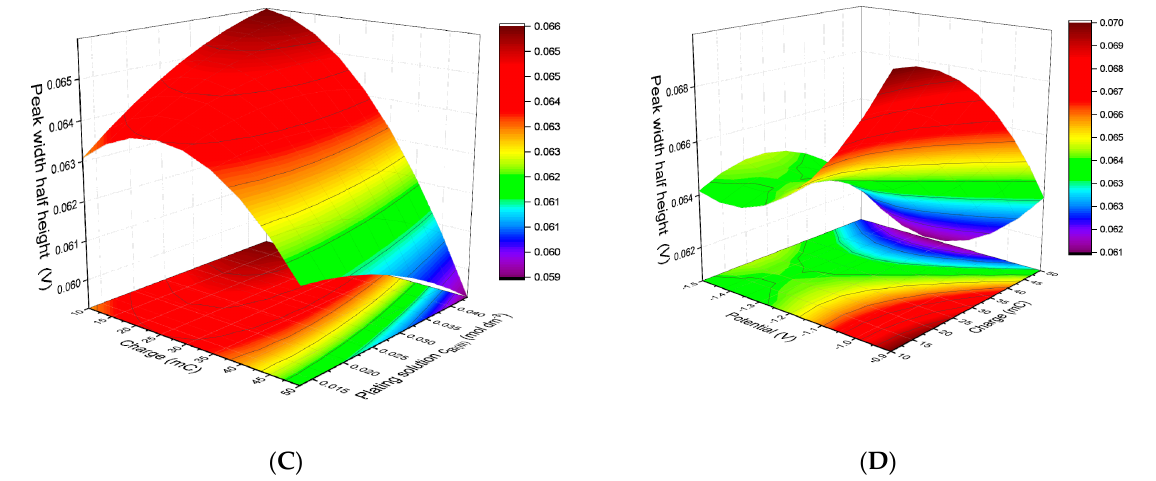
Figure 2. Response surfaces for Ge(IV) peak current ( A , B ) and the half width potential of Ge(IV) ( C , D ).